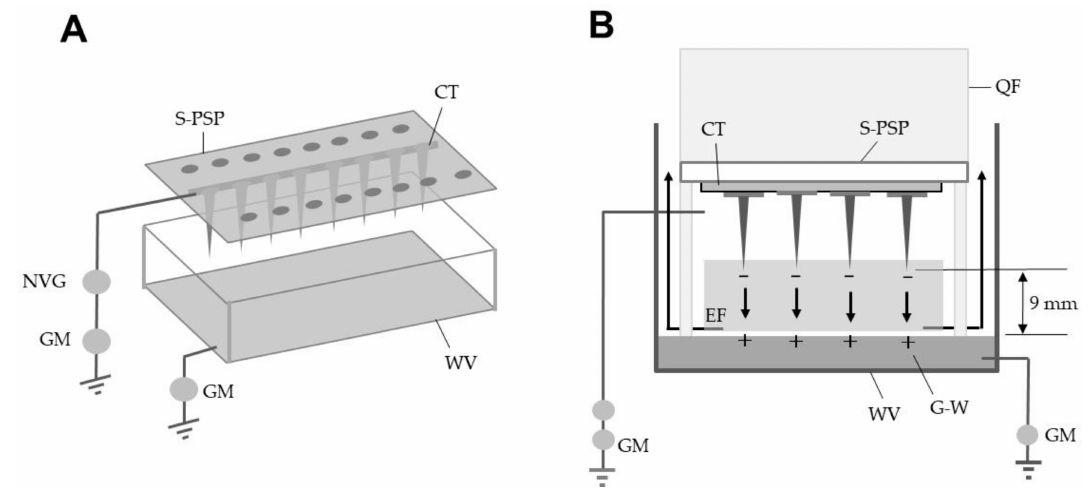
Figure 1. Schematic representation of the corona discharge-generating apparatus (CDA) consisting of a spiked perforated stainless plate and a water vessel ( A ) and the electric field between the spike tips and the grounded water surface (cross- sectional view) ( B ). The arrow in ( B ) represents the direction of the ionic wind produced in the electric field. S-PSP, spiked perforated stainless plate; CT, conductive double-sided adhesive tape; GM, galvanometer; NVG, negative voltage generator; EF, electric field; QF, quadrangular hood; WV, water vessel; G-W, grounded